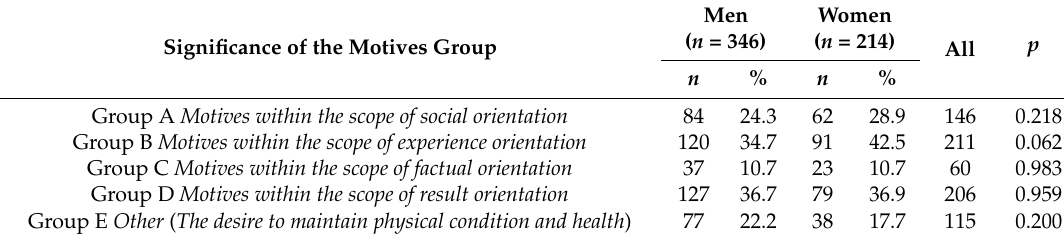
Table 12. Significance of particular groups of motives covered by the